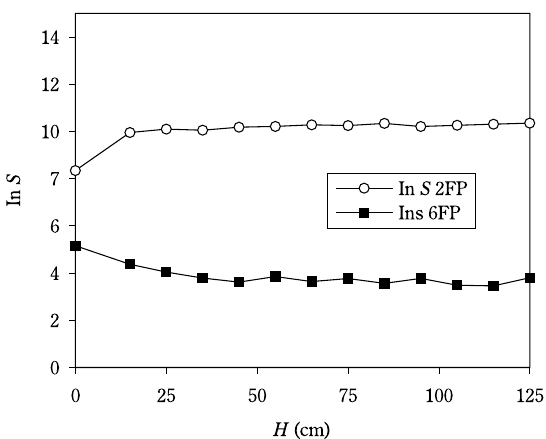
Fig. 4 Change in supersaturation with reactor height for 2FP and